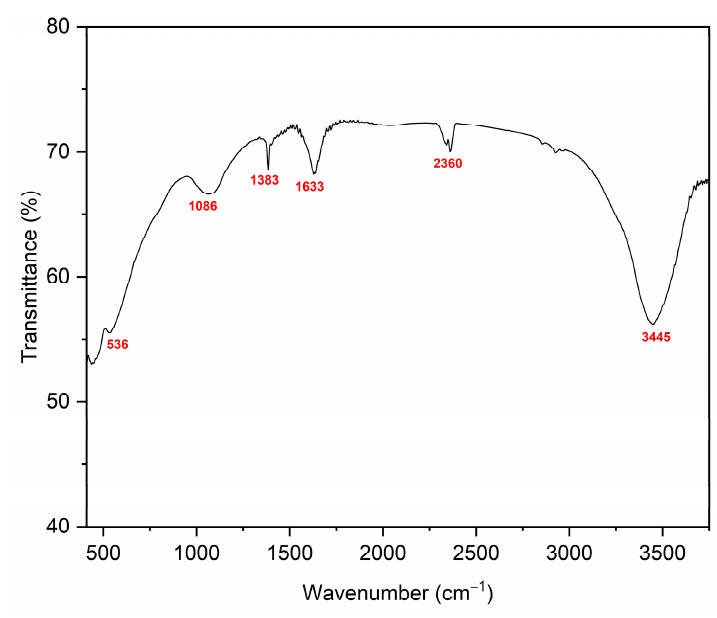
Figure 3. The distinctive vibrations with wave numbers at 1083 cm − 1 (corresponds to Si-O), 912 cm − 1 (corresponds to Al-OH), and 752 cm − 1 (corresponds to Si-O-Si) demonstrate the presence of HNTs in rGO/HNT. No vibration of the carboxyl group (1714 cm − 1 ) was observed, showing that elaboration of rGO/HNT involved the reduction of GO to rGO. The C=C and C=O groups of rGO have stretching vibrations that cause peaks at 1633 cm − 1 and 1086 cm − 1 [37,38]. A weak vibration at the wavenumber of 2360 cm − 1 is characteristic of the C=O bond, indicating that a small portion of graphene oxide has not been completely reduced. In addition, vibrations at wavenumbers of 1383 cm − 1 and 3445 cm − 1 indicate the Figure 2. Raman spectra of CuFe 2 O 4 -70%/rGO/HNT. presence of OH groups in the halloysite nanotube composition, in rGO and adsorbed water in the synthesized catalyst. The existence of CuFe 2 O 4 bonding with rGO/HNT is shown by the 530 cm − 1 characteristic vibrations [39,40].